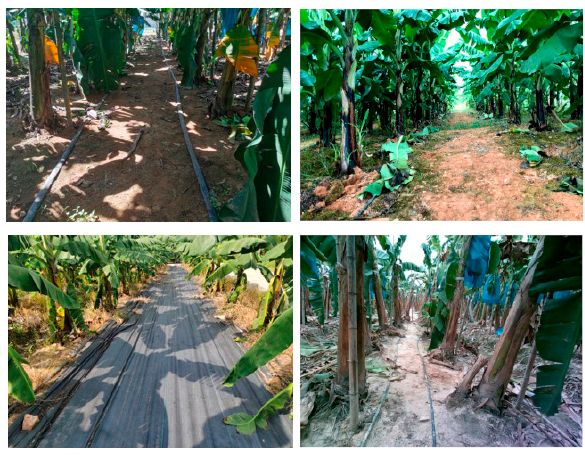
Figure 2. Raw data collection environment.